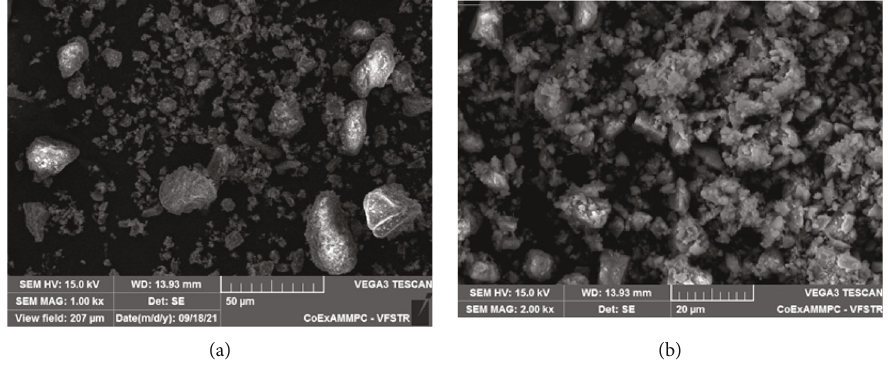
Figure 3: (a) SEM analysis — before adsorption. (b) SEM analysis — after